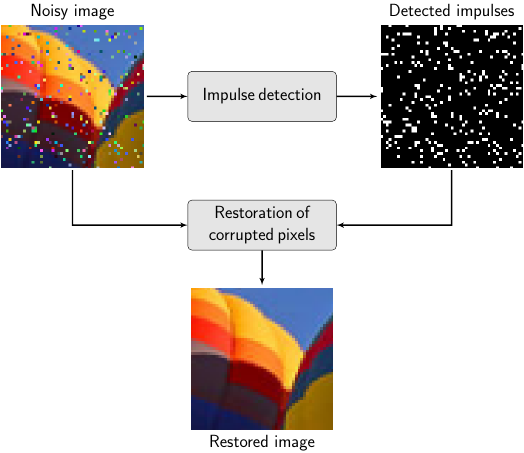
Figure 1. A general scheme of a switching filter. Only the pixels identified as corrupted are being restored and the remaining pixels are